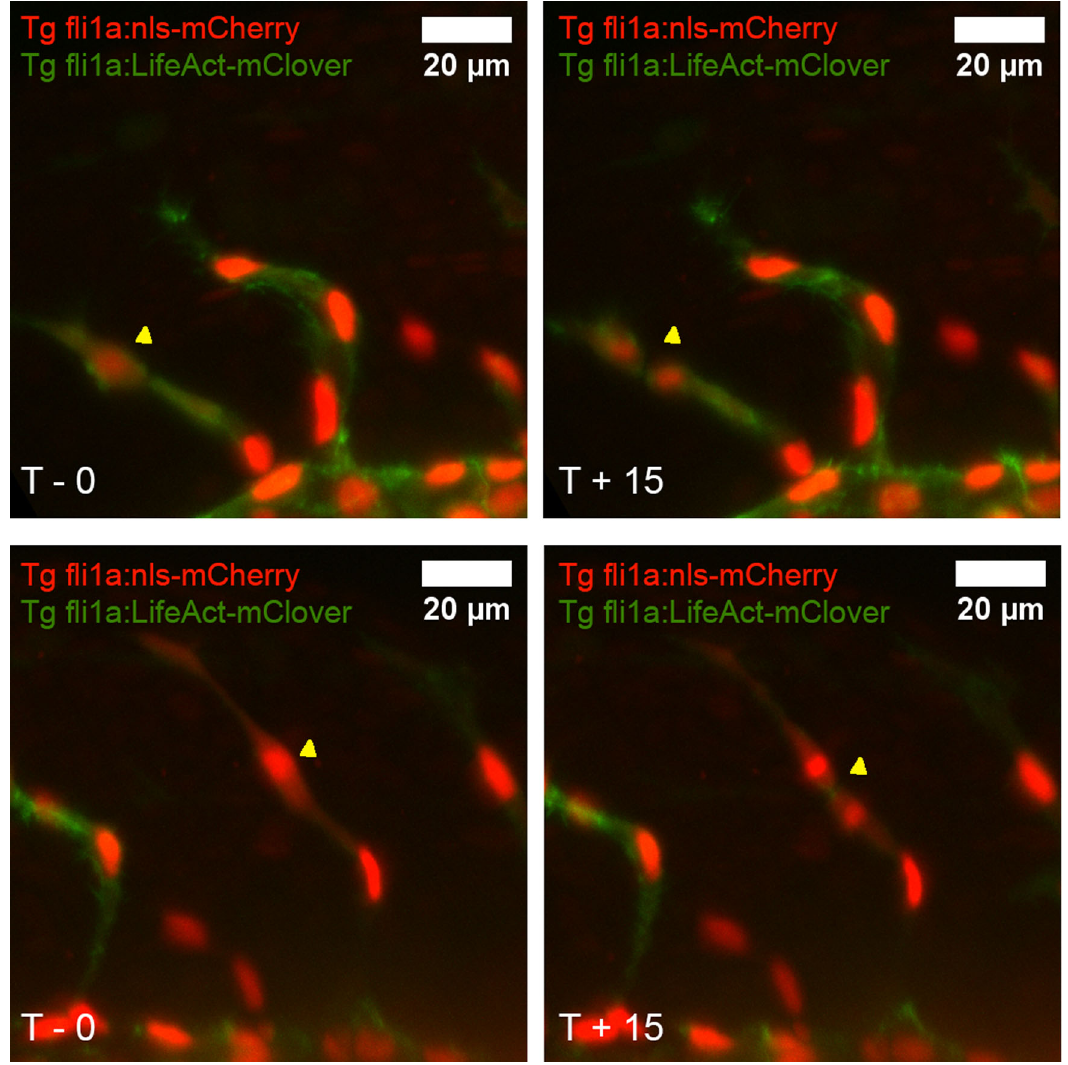
labelled using the transgenic marker fli1a:nls-mCherry (red) whilst endothelial F-actin was labelled using fli1a:lifeAct- mClover (green). EC proliferation wasdefined as where one nucleus visiblydivides intotwo (examples areshown and dividing cells are labelled with yellow arrows; compare upper left with upper right; compare lower left with lower